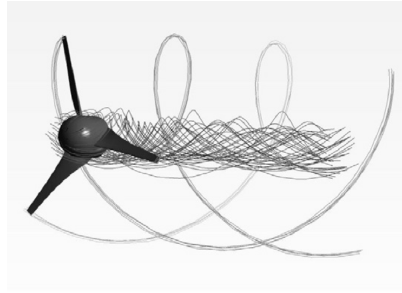
Figure 12. A 3D wind turbine model by Lanzafame et al. [118].